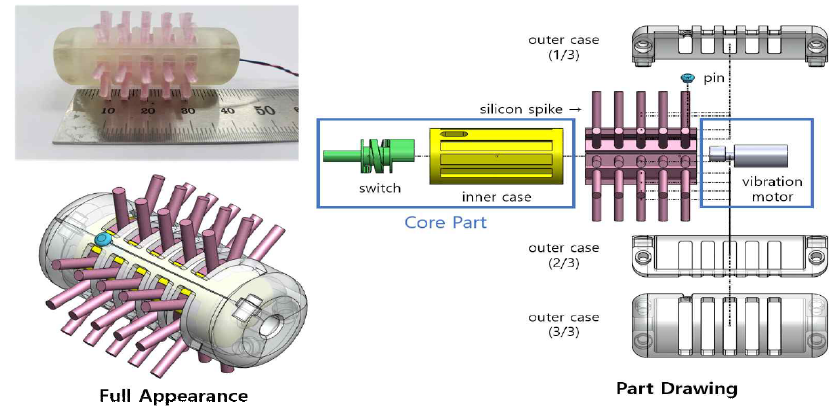
Figure 1. The appearance and part assemblies of the proposed HSA. The switch is a sort of all-in-one mechanism that allows the HSA to generate vibration and change the moving direction by a single